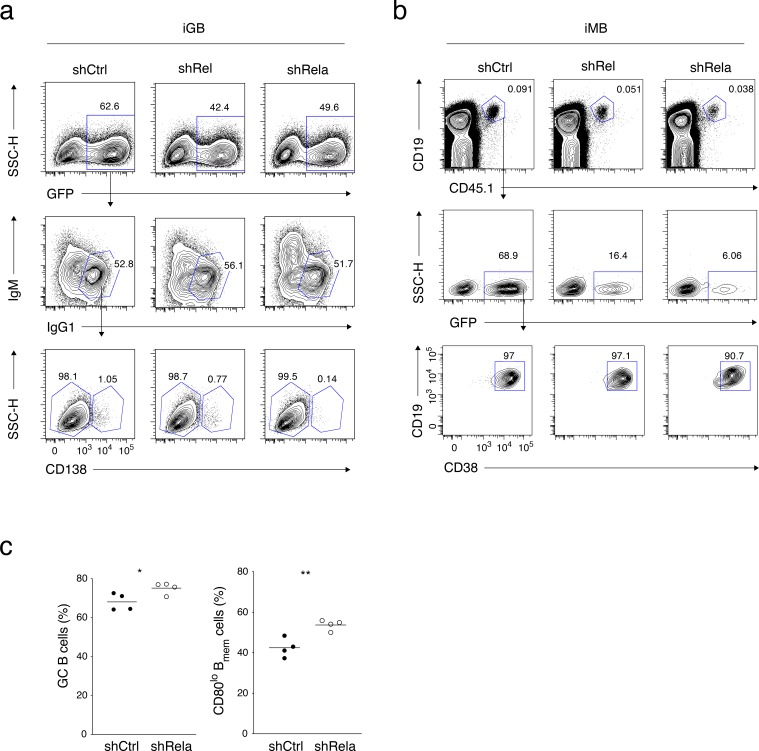
Gating strategies for the analyses in Figure 6d and f, and comlementary data for Figure 6h.(a) A representative FCM data showing the gating strategy for the gene-transduced IgG1+ CD138− iGB cells analyzed in Figure 6d. (b) Representative FCM data showing the gating strategy for the gene-transduced iMB cells analyzed in Figure 6f. (c) The frequencies of GC B cells (CD19+ CD38−) in the donor-derived, antigen-specific, class-switched, gene-transduced B cells (CD45.1+ NP+ IgM− GFP+) (left), and the frequencies of CD80lo cells in the gene-transduced Bmem cells (CD45.1+ NP+ GFP+ IgM− CD19+ CD38+), for the mice shown in Figure 6h (n = 4).